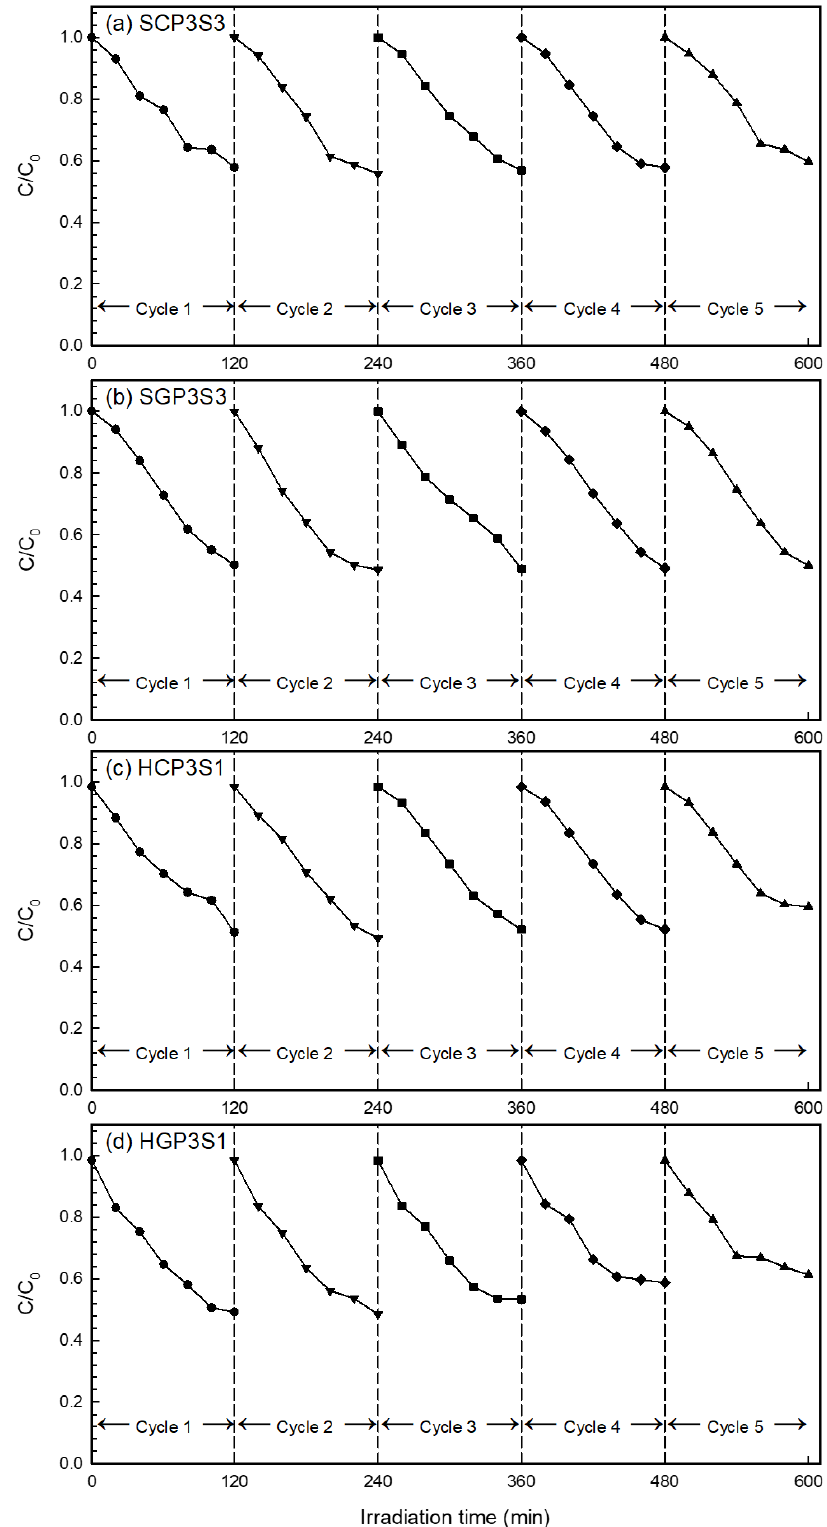
Figure 10. Cyclic photocatalytic capability of immobilized photocatalysts. (a) SCP3S3; (b) SGP3S3; (c) HCP3S1; and (d) HGP3S1.